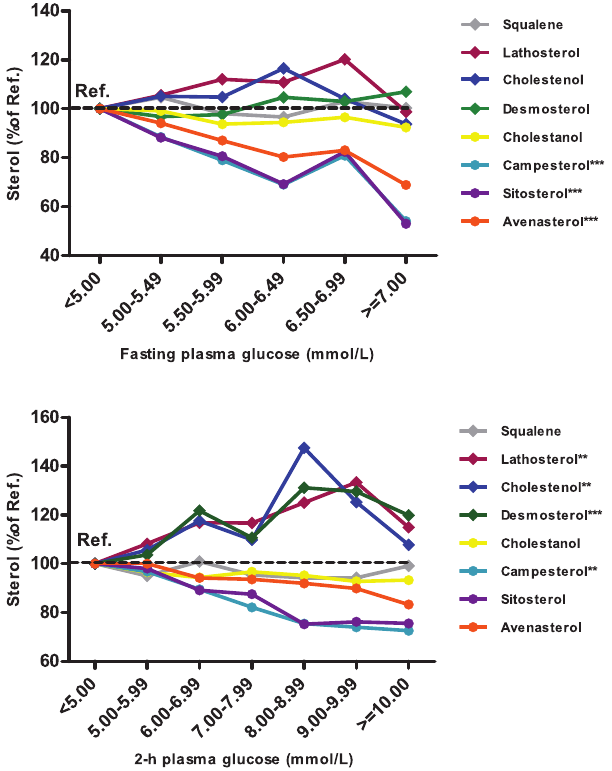
Figure 1. Non-cholesterol sterols indicating cholesterol syn- thesis (diamonds) and absorption (circles) in relation to hyperglycemia, according to the categories of fasting (FPG) and 2-hour plasma glucose (2hPG) levels (N=746). Data points represent unadjusted means of sterol levels in each glucose category. P values were calculated using general linear model adjusted for age, BMI, smoking, and physical activity: ** P , 0.01, *** P , 10 2 5 . Individuals with previously diagnosed diabetes and on statin or ezetimibe